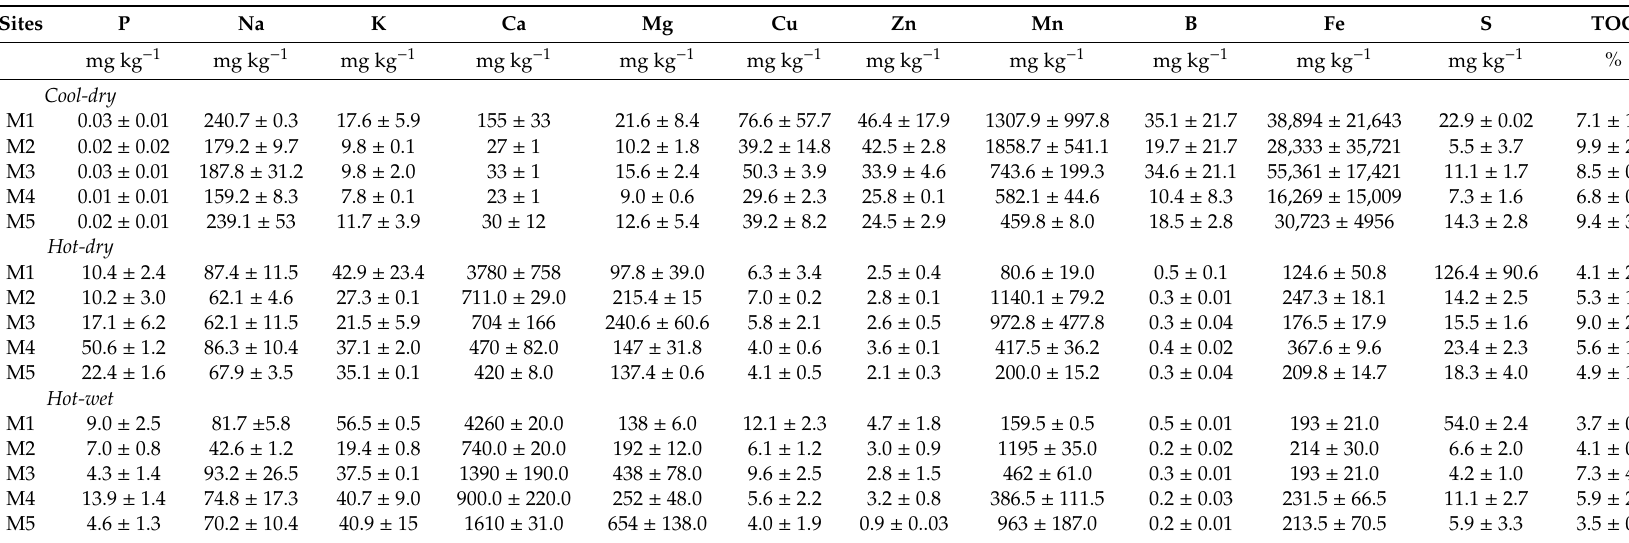
Table 1. Variation in sediment quality variables recorded across five sites (M1–M5) and three seasons (cool-dry, hot-dry, hot-wet) in the Mvudi River, South Africa.